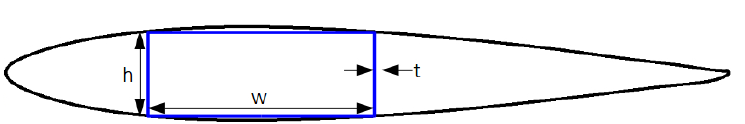
Figure 10. Box beam model to scale the thickness for stable wing response.